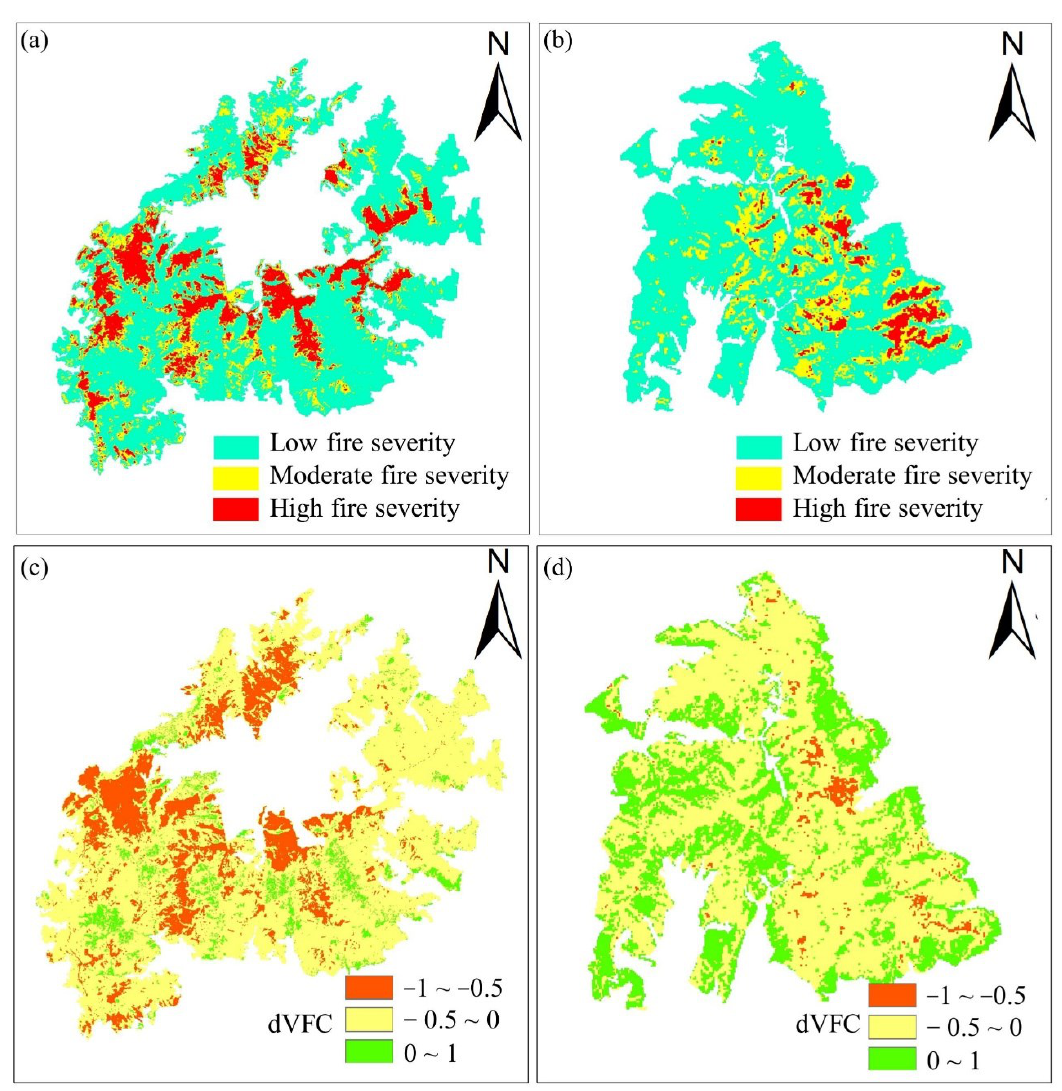
Figure 7. Fire intensity and the difference between the post-fire VFC and the pre-fire VFC (d VFC ) distributions in Muli County and Jingjiu Township. ( a , b ) fire intensity distributions in Mulli County and Jingjiu Township, respectively. ( c , d ) the d VFC distributions in Mulli County and Jingjiu Township, respectively.